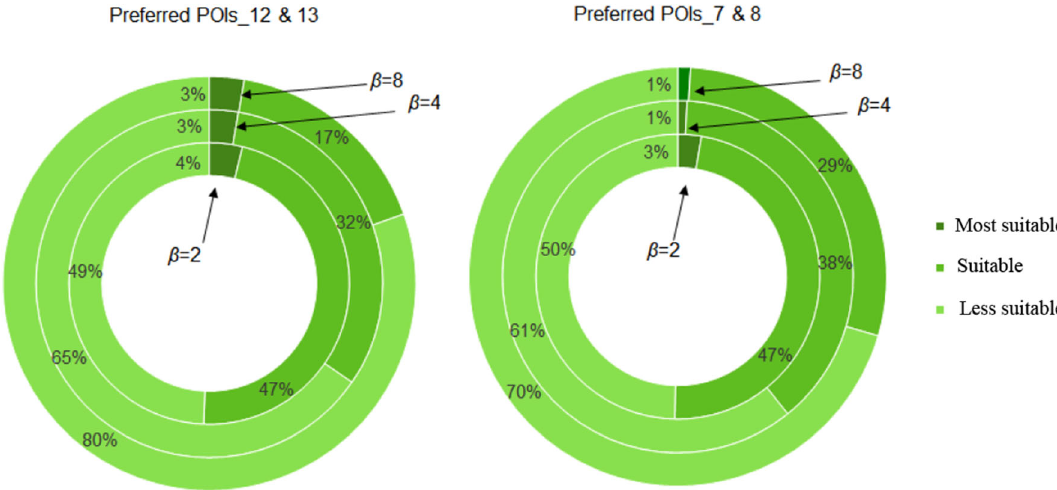
Fig. 13 Distribution of zones’ suitability for different b values and preferred